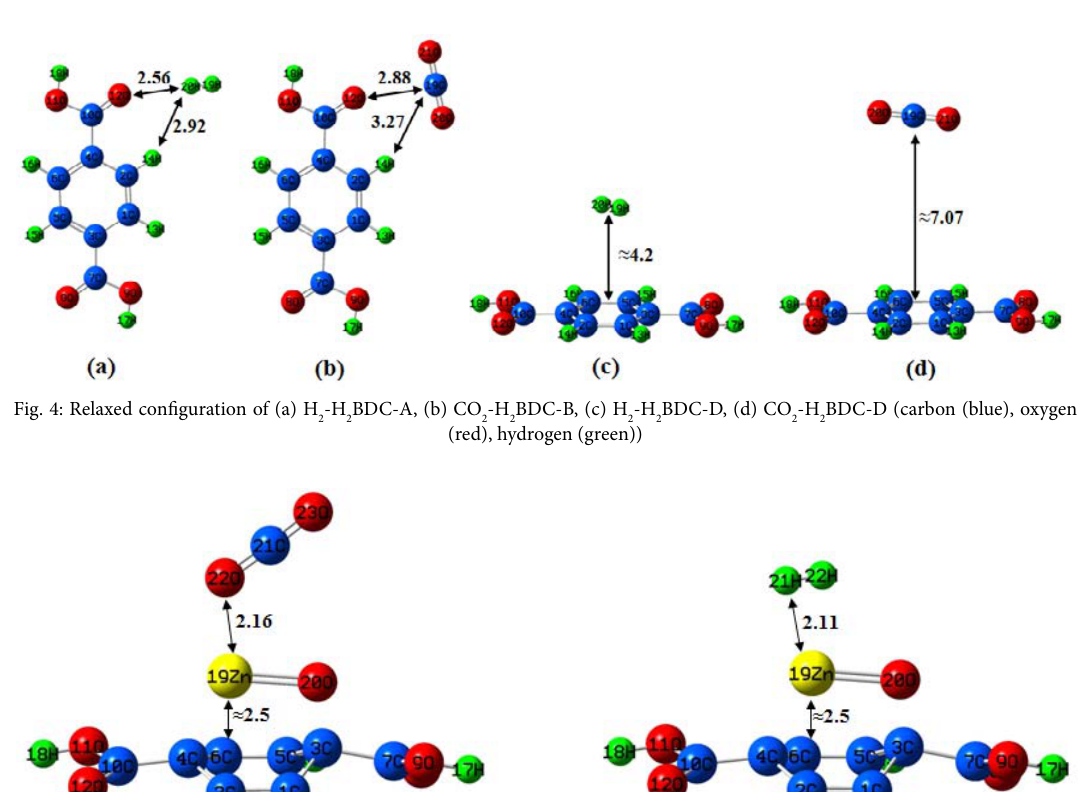
-ZnO-H BDC and (b) CO -ZnO-H BDC (carbon (blue), oxygen (red), hydrogen (green), 2 2 2 2 zinc